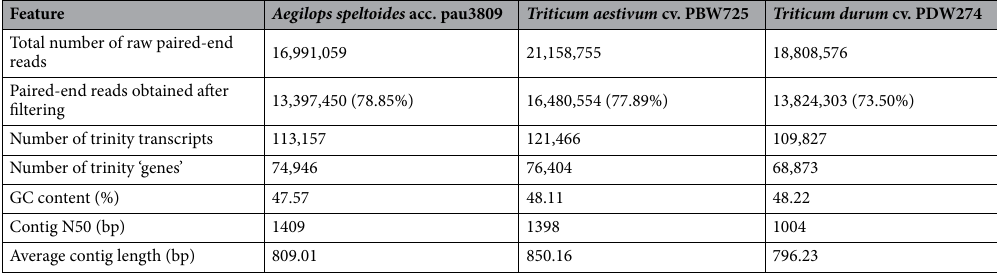
Table 1. Summary of paired-end sequencing data (2 × 100 bp) and de novo transcriptome assembly statistics for Ae. speltoides acc. pau3809, T. aestivum cv. PBW725 and T. durum cv.